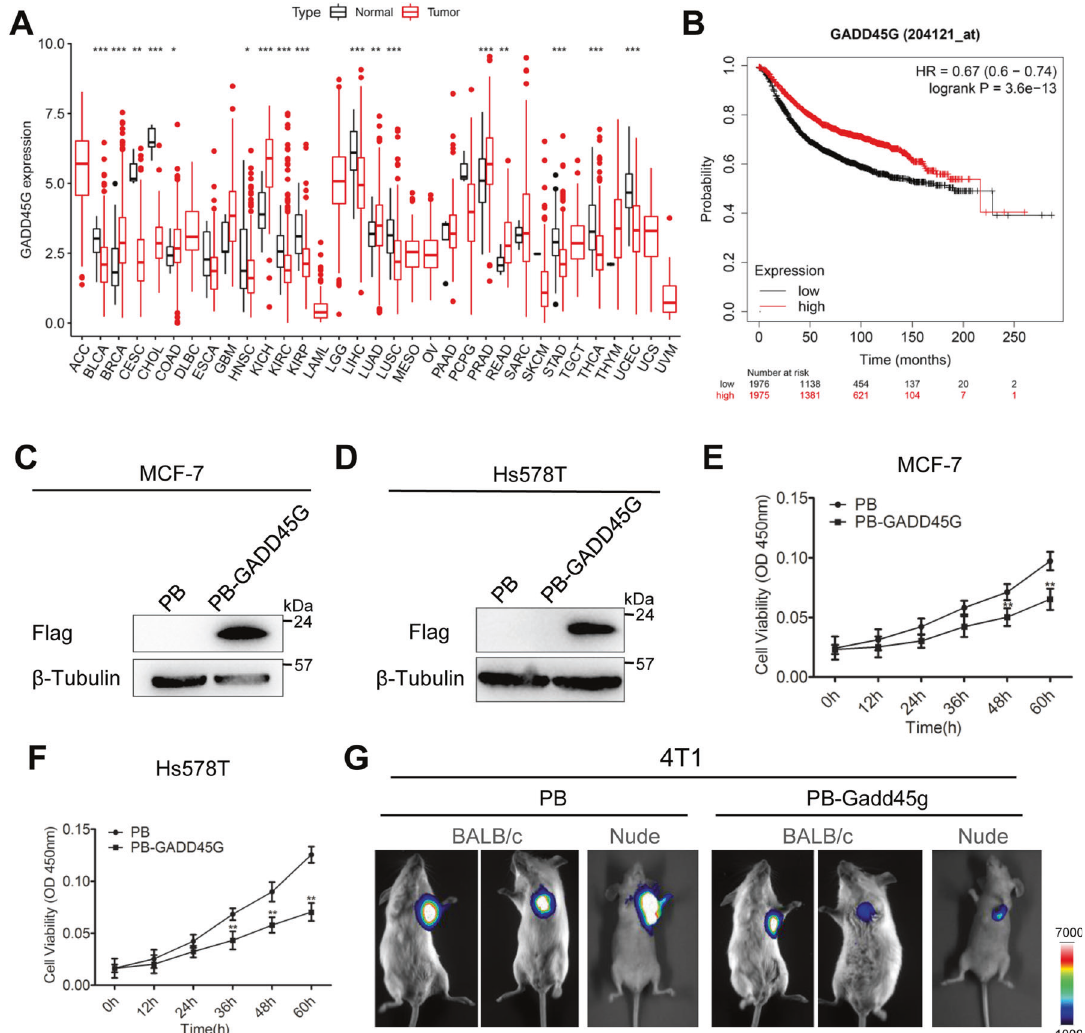
Fig. 5 Overexpression of GADD45G limits the propagation of breast cancer cells. A Analysis of GADD45G expression in different kinds of normal and cancer samples from TCGA database. B The expression level of GADD45G is related to the overall survival time of breast cancer patients. C , D Western blot analysis of FLAG in MCF7 and Hs578T cells overexpressing FLAG-tagged human GADD45G (PB-GADD45G) or empty vector. β -tubulin was used as a loading control. E , F CCK8 assay was performed to assay the effects of GADD45G on the proliferation of MCF7 and Hs578T cells. The data are represented as the means ± s.d. ( N = 3 independent biological experiments). ** p < 0.01. G Luciferase- tagged mouse breast cancer cell line 4T1 stably expressing PB or PB-Gadd45g were transplanted in BALB/c and nude mice. Luciferase signals were captured by Tanon-5200Multi